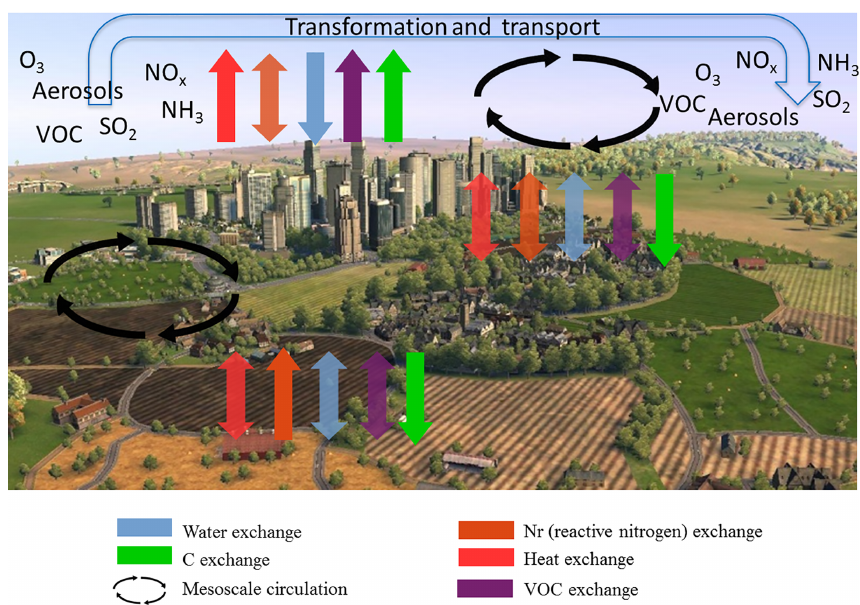
Figure 4. Interactions between different land uses and major trend of gaseous flux direction from each land use type. Different colours represent different scalars. Monodirectional arrows indicate where scalars are mostly emitted or deposited by the land use. Bidirectional arrows indicate where scalars can be emitted or deposited depending on atmospheric and ecosystem